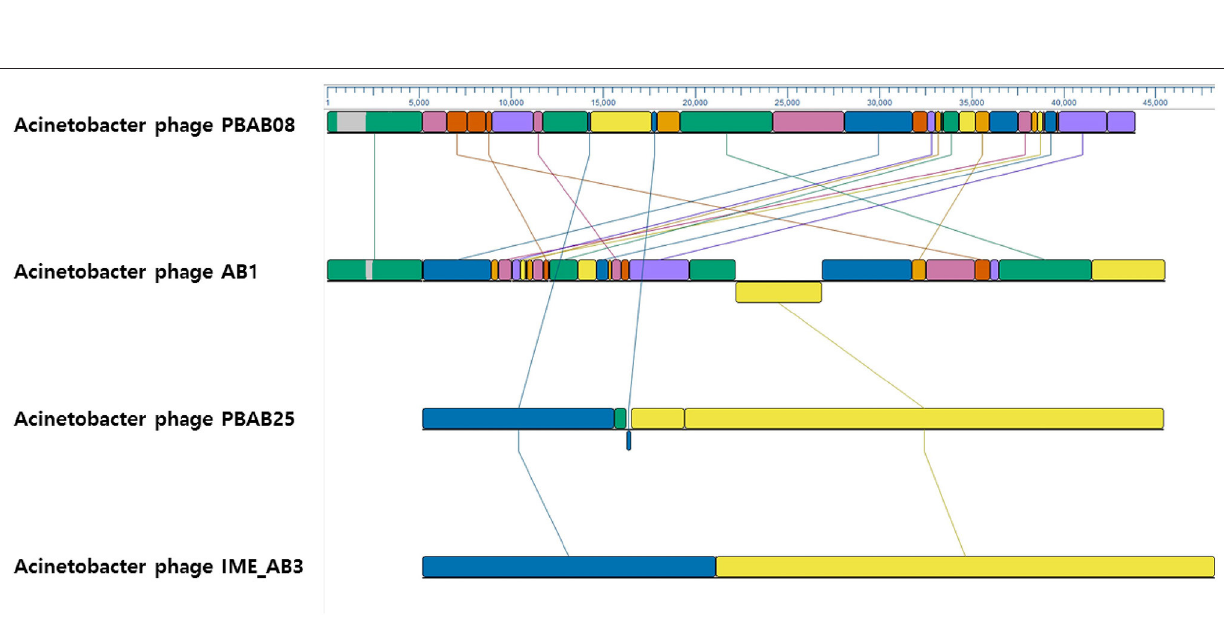
Frontiers in Microbiology | www.frontiersin.org